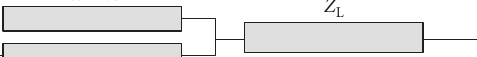
Figure 2: Equivalent circuit with load z